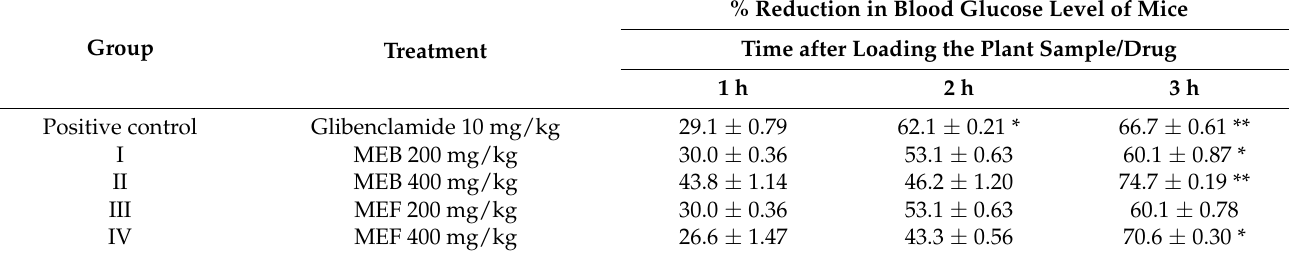
Table 3. Hypoglycemic effect in terms of % reduction in blood glucose level of methanolic ex- tract of bark (MEB) and methanolic extract of fruit coat (MEF) of W. coccinea on glucose-induced hyperglycemic mice